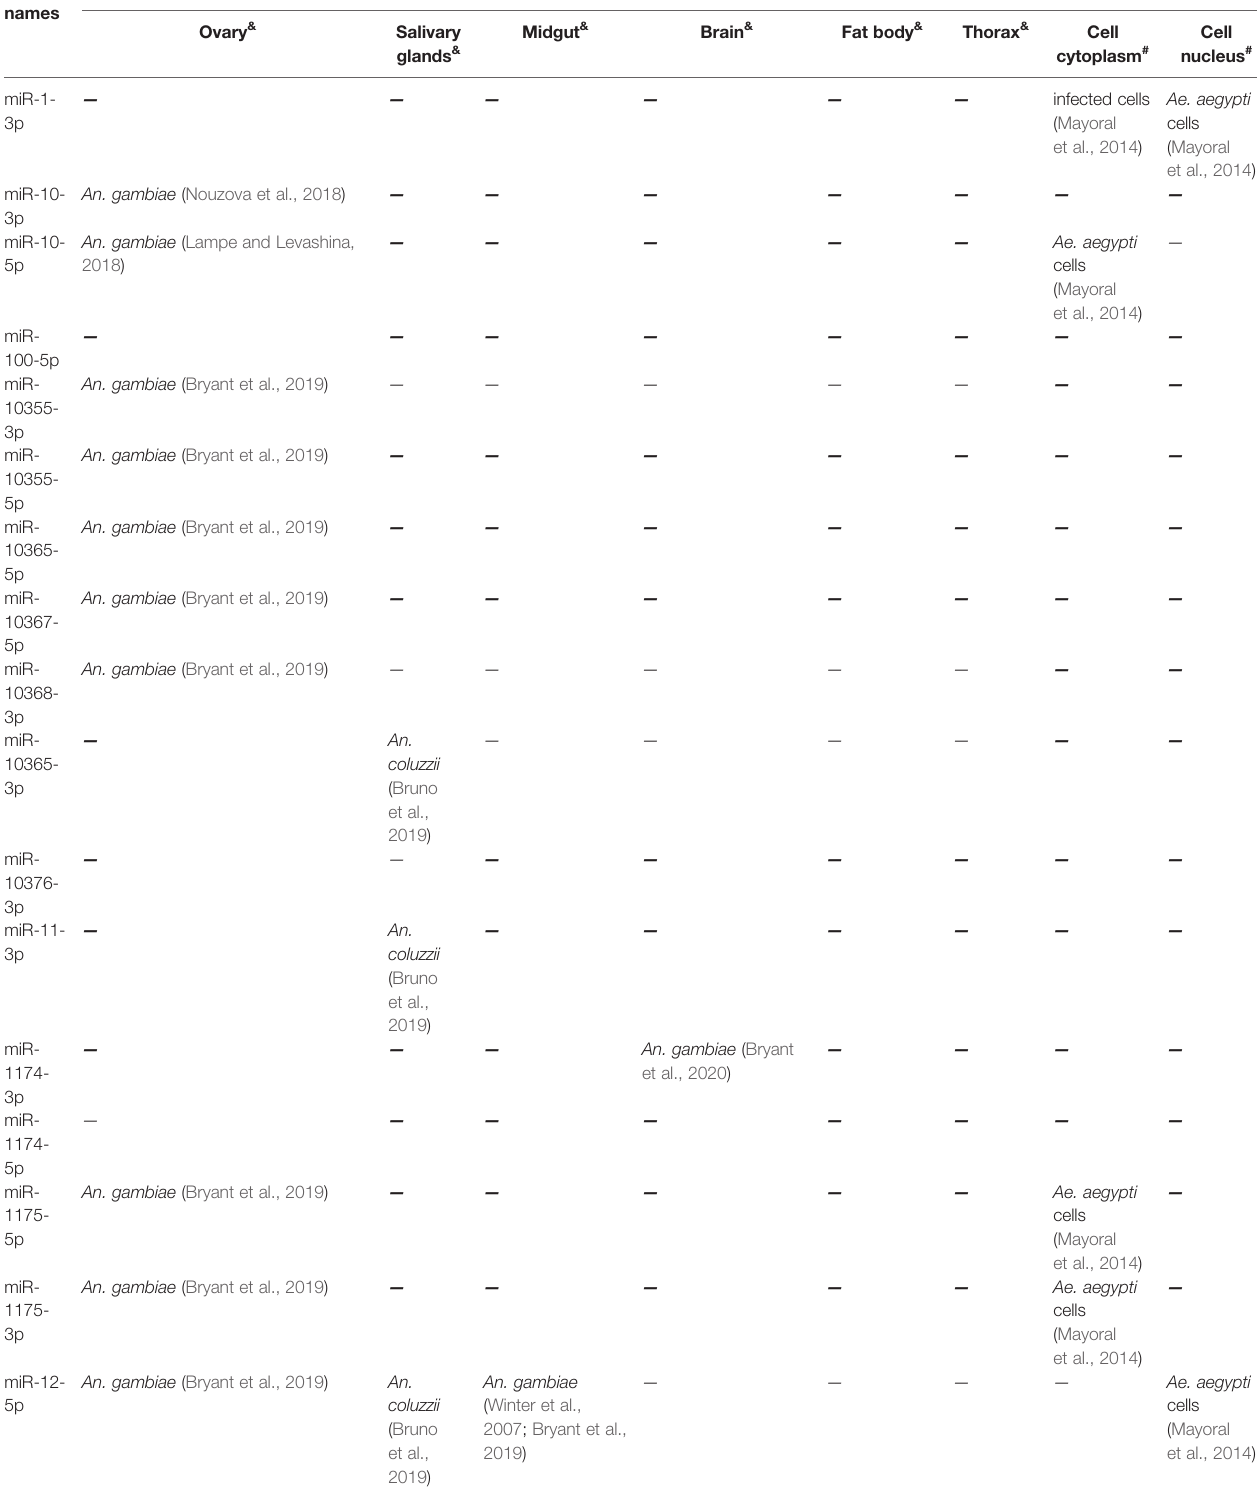
TABLE 5 | Tissue-, organ- or cell compartment- speci fi c miRNAs. miRNA